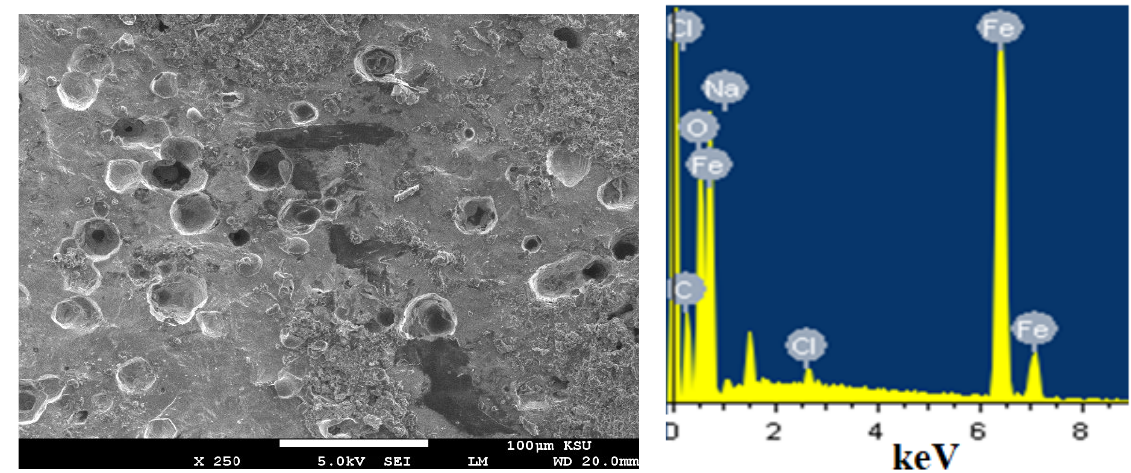
Figure 13. SEM image and EDX profile spectrum after 1 h with a potential of −4 75 mV (Ag/AgCl) for the surface of the iron rod that was immersed for 48 h in 3.5% NaCl solution before measurement.